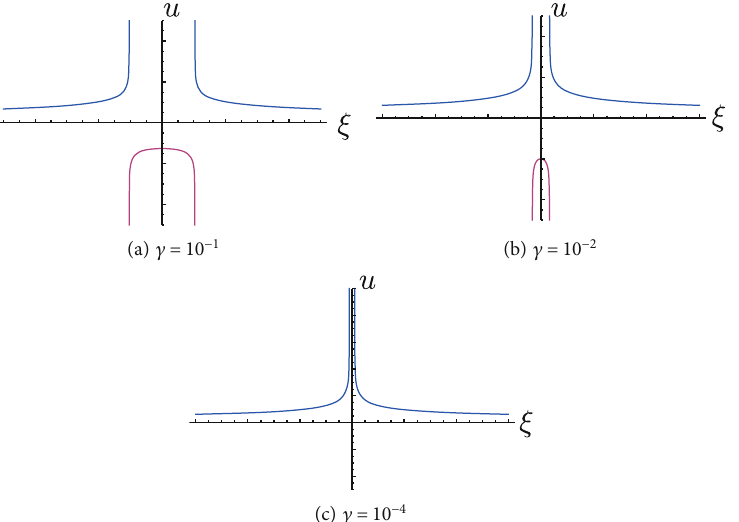
ð ξ Þ when κ = 0, p = 9, α − c = 0, γ = 1 , and β ⟶ 0 − 0 1